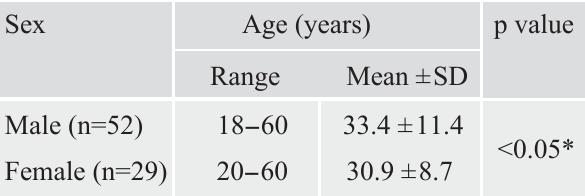
Table I: Distribution of the patients by age and sex